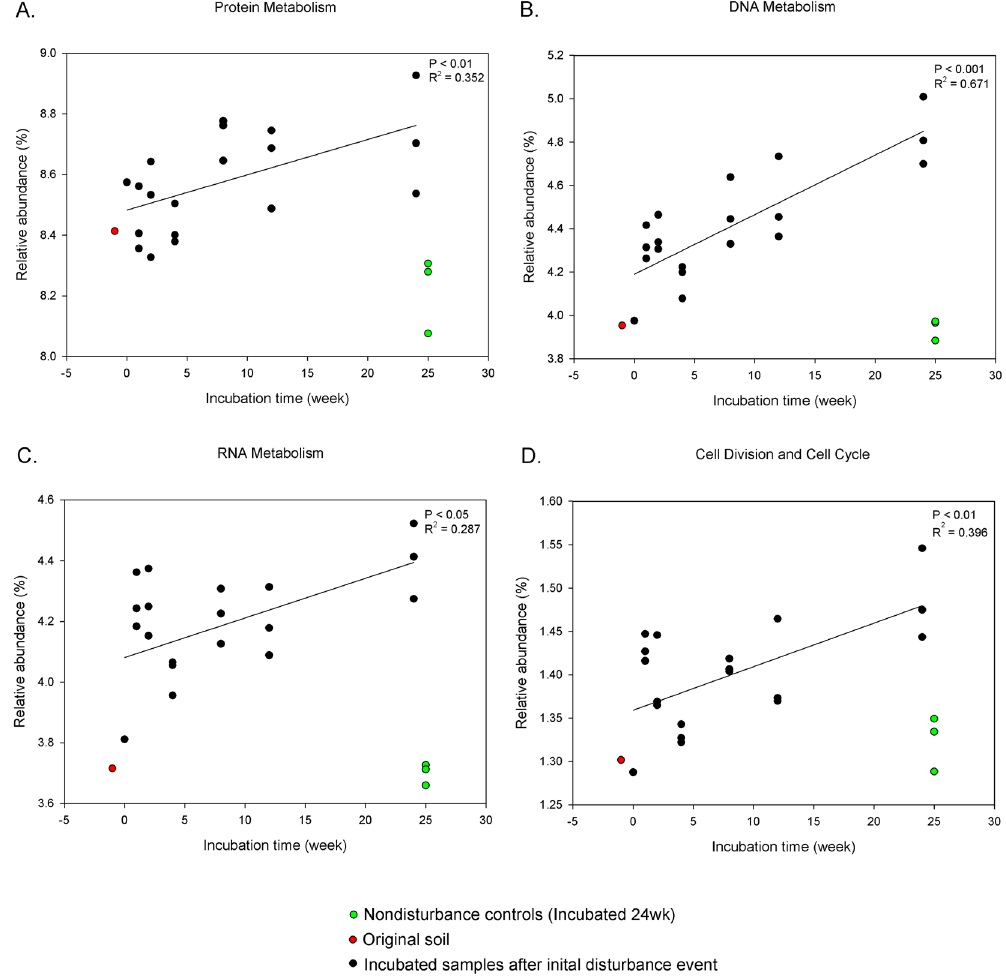
Figure 4. Relationship between incubation time and relative abundance of functional gene categories at subsystem level 1 (SEED database). Solid line represents linear regression fits to data. ( A ) Protein metabolism, ( B ) DNA metabolism, ( C ) RNA metabolism, ( D ) Cell division and cell cycle. Colored points were not included in the